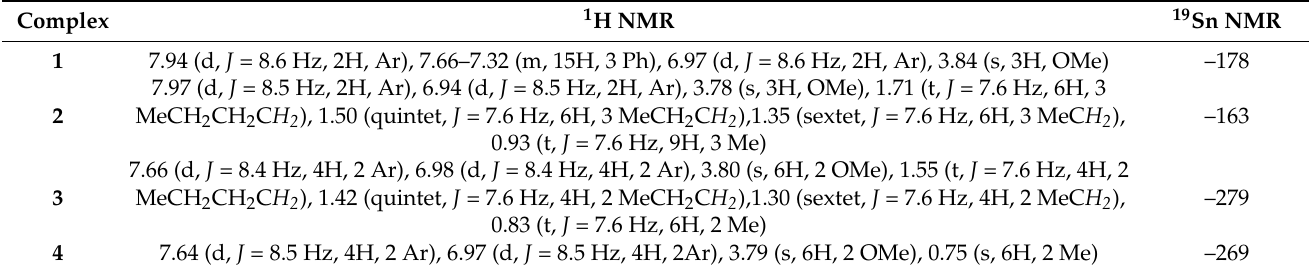
Table 3. Nuclear magnetic resonance NMR spectral data of complexes 1 – 4